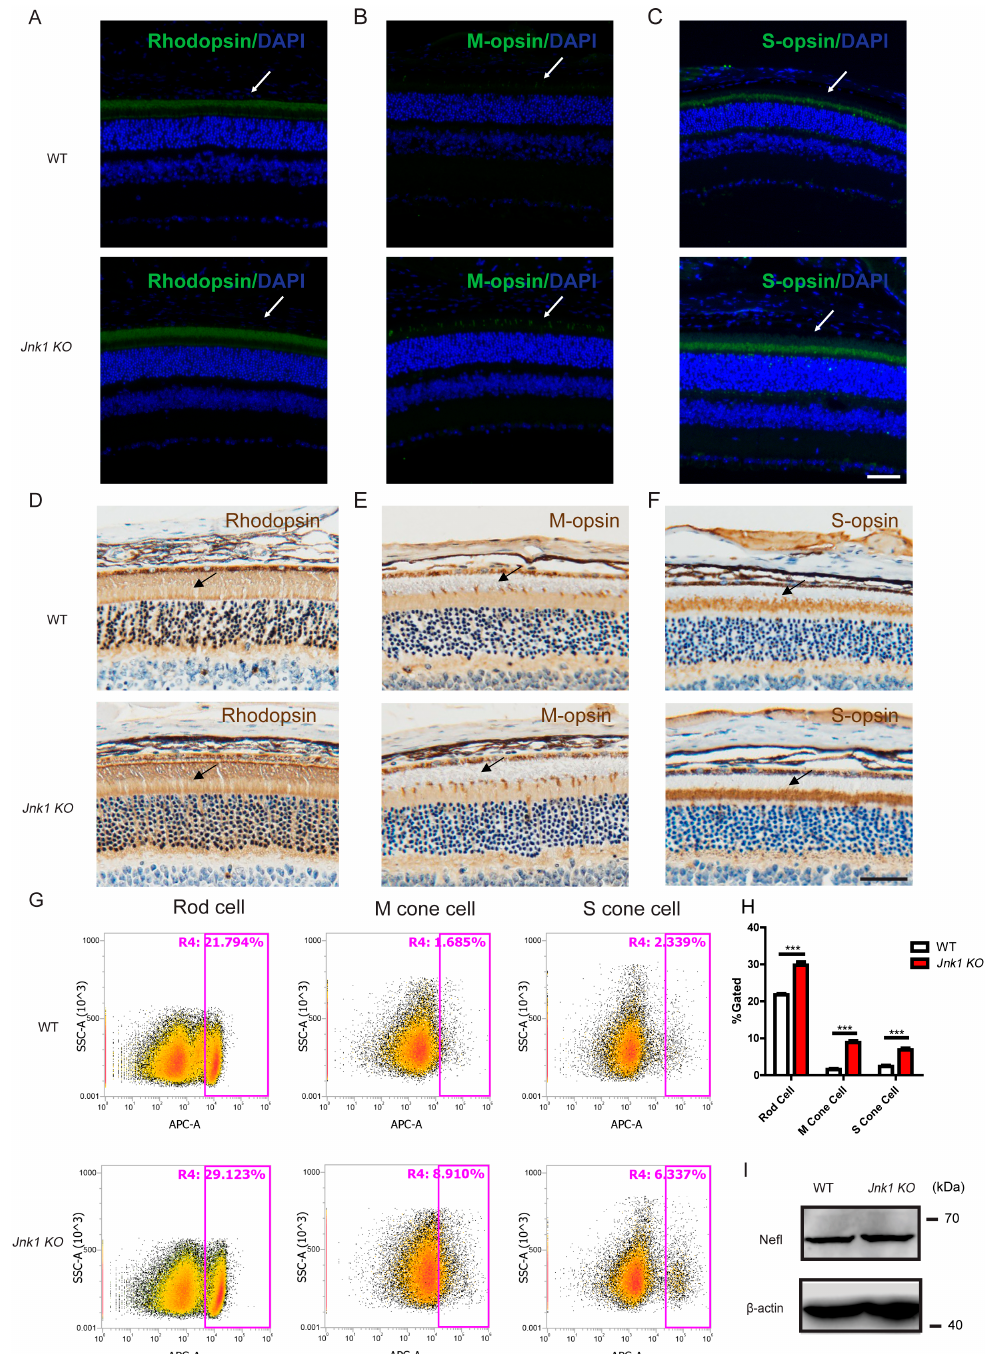
Figure 2. Increased production of photoreceptors in Jnk1 KO mice. ( A – C ) Section immunofluorescence on WT and Jnk1 KO retinas at P30: (A) Rhodopsin, (B) M-opsin, (C) S-opsin. Arrows point to these proteins. Scale bars: 50 μ m. ( D–F ) Section immunohistochemistry on WT and Jnk1 KO retinas at P30: (D) Rhodopsin, (E) M-opsin, (F) S-opsin. Arrows point to these proteins. Scale bars: 50 µ m. ( G , H ) Rhodopsin-positive cells (Rod cells), S-opsin-positive cells (S cone cells), and M-opsin-positive cells (M cone cells) from WT and Jnk1 KO mice retinas were quantified by flow cytometry. Graphs show the mean ± SEM, and the data shown are representative of three retinas. *** p < 0.001 (Wilcoxon–Mann– Whitney test). ( I ) Eyes were isolated from WT and Jnk1 KO mice at P30. Tissue homogenate was collected for western blot analysis using an anti-Nefl (Neurofilament Light) antibody to indicate ganglion